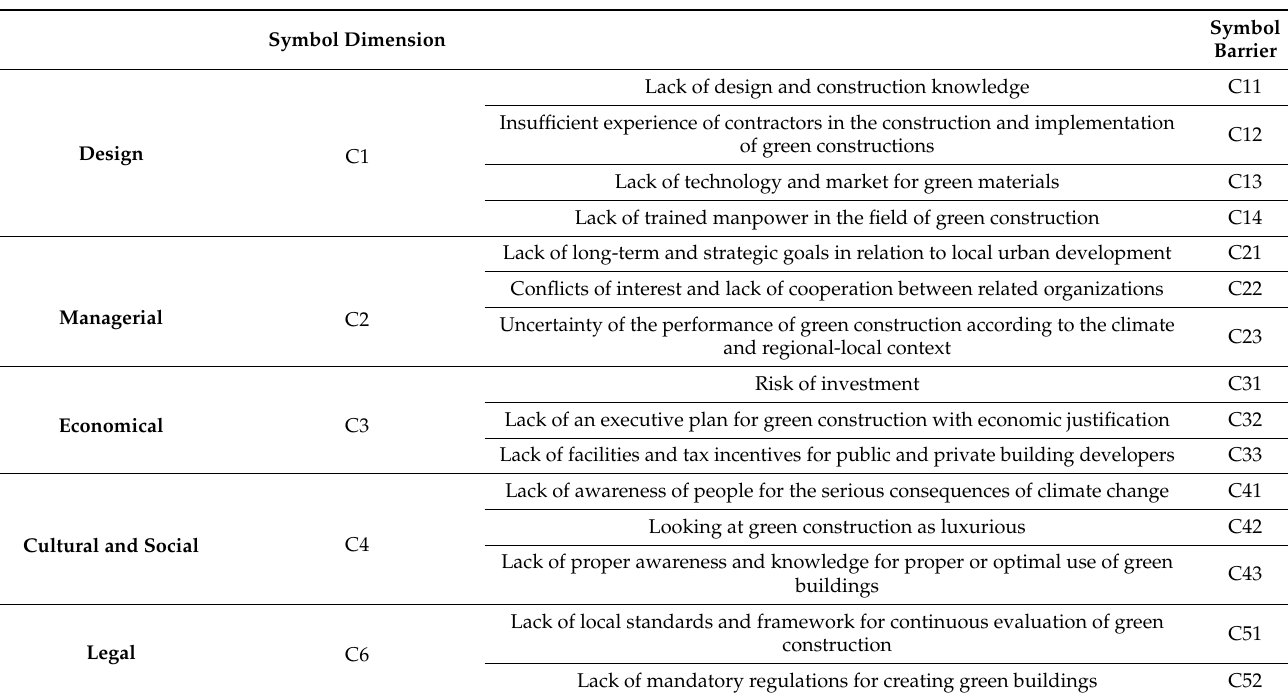
Table 4. Confirmed barriers for